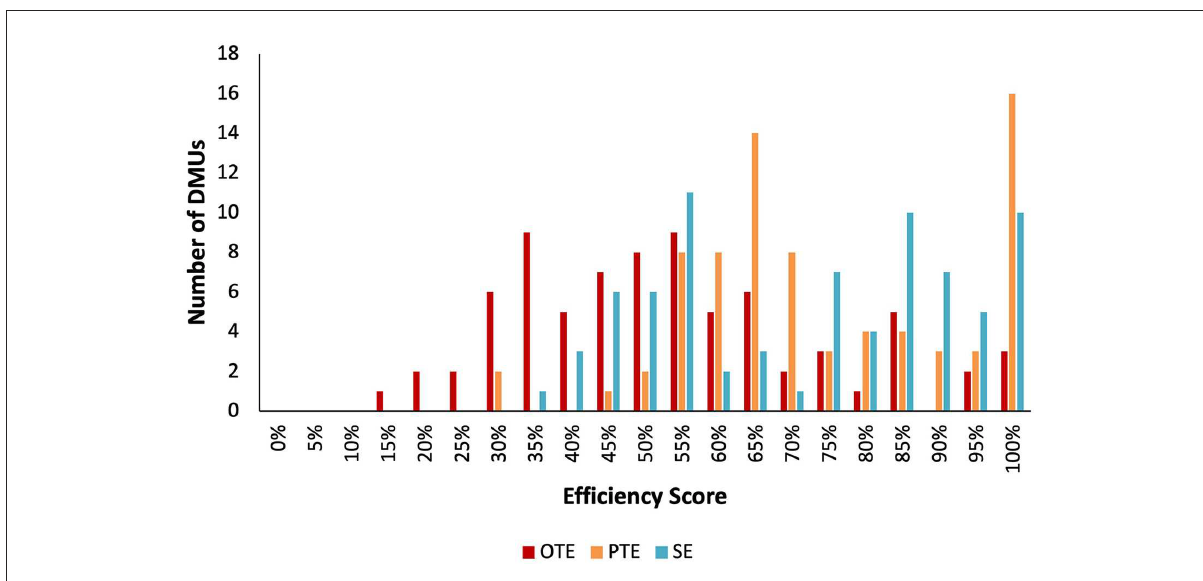
FIGURE1 Overall technical efficiency, pure technical efficiency, and scale efficiency scores